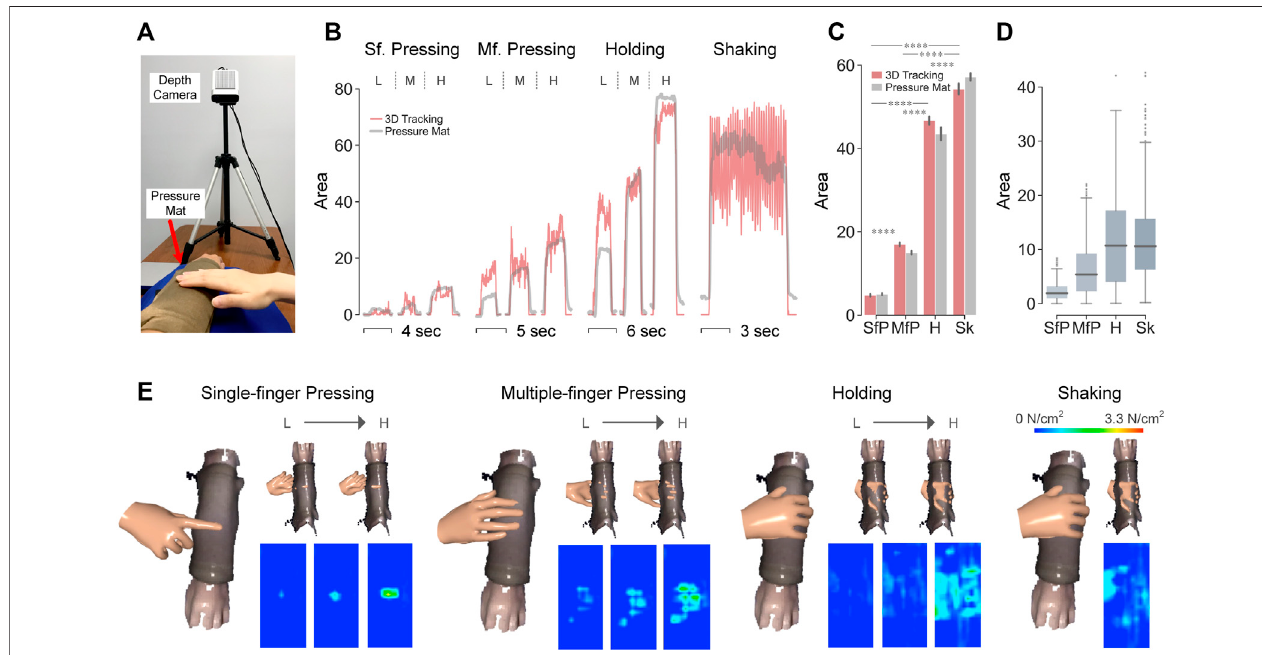
FIGURE7| Validationofcontactareameasurementsusingsensorizedpressuremat. (A) Experimentalsetup. (B) Contactarea(cm 2 )overtimebythetwosystems. Forthe fi rstthreetestgesturesareshownonetrialperforcelevel,i.e.,low,medium,andhighforce. (C) Meanvaluesofcontactarea(cm 2 )pertestgesture.**** p < 0.0001 were derived by paired-sample Mann – Whitney U tests. (D) Differences of measured contact area (cm 2 ) between the two systems per test gesture. (E) Visualization of hand-arm contact in top view (left) and bottom view (top right) with heatmaps of contact pressure tracked by sensorized pressure mat across force levels (bottom